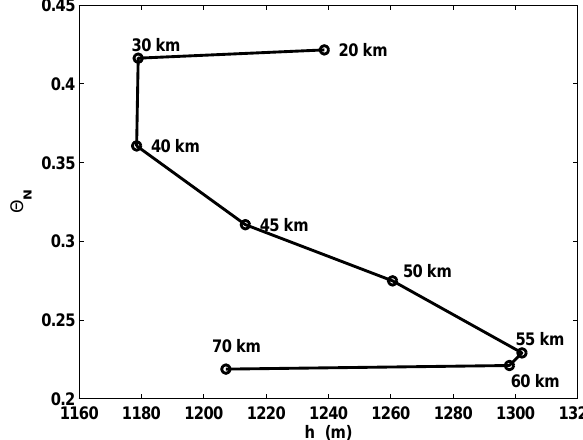
Fig. 4. Modelled ice flux across the grounding line (blue), and ice flux calculated from Eq. ( 17) (red) from Schoof (2007a). The re- sults shown are for a channel with a half-width w c = 60km. The x axis shows the distance along the grounding line, with x = 0 being at the symmetry axis of the model domain where the grounding line crosses the medial line. Despite the grounding line curving some- what in that region, the range − 60km ≤ x ≤ 60km broadly coin- cides with the deepest section of the channel. The flux ( q ) shown is the vertically integrated flux, i.e. q = ρhv n , where v n is the veloc- ity normal to the grounding line.